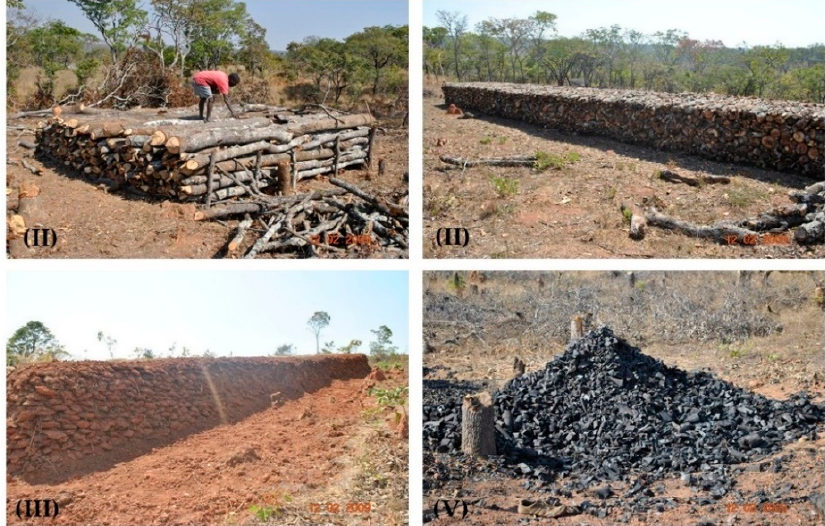
Figure 2. Processes of charcoal production by traditional earth kiln. Upper images ( II ) show the process of log piling into clamp, and the lower left image ( III ) shows covering of the clamp with dung and soil lumps, while the lower right image ( V ) shows the harvesting of charcoal and packaging it into bags. The steps number ( I , IV ) are not represented in this figure.